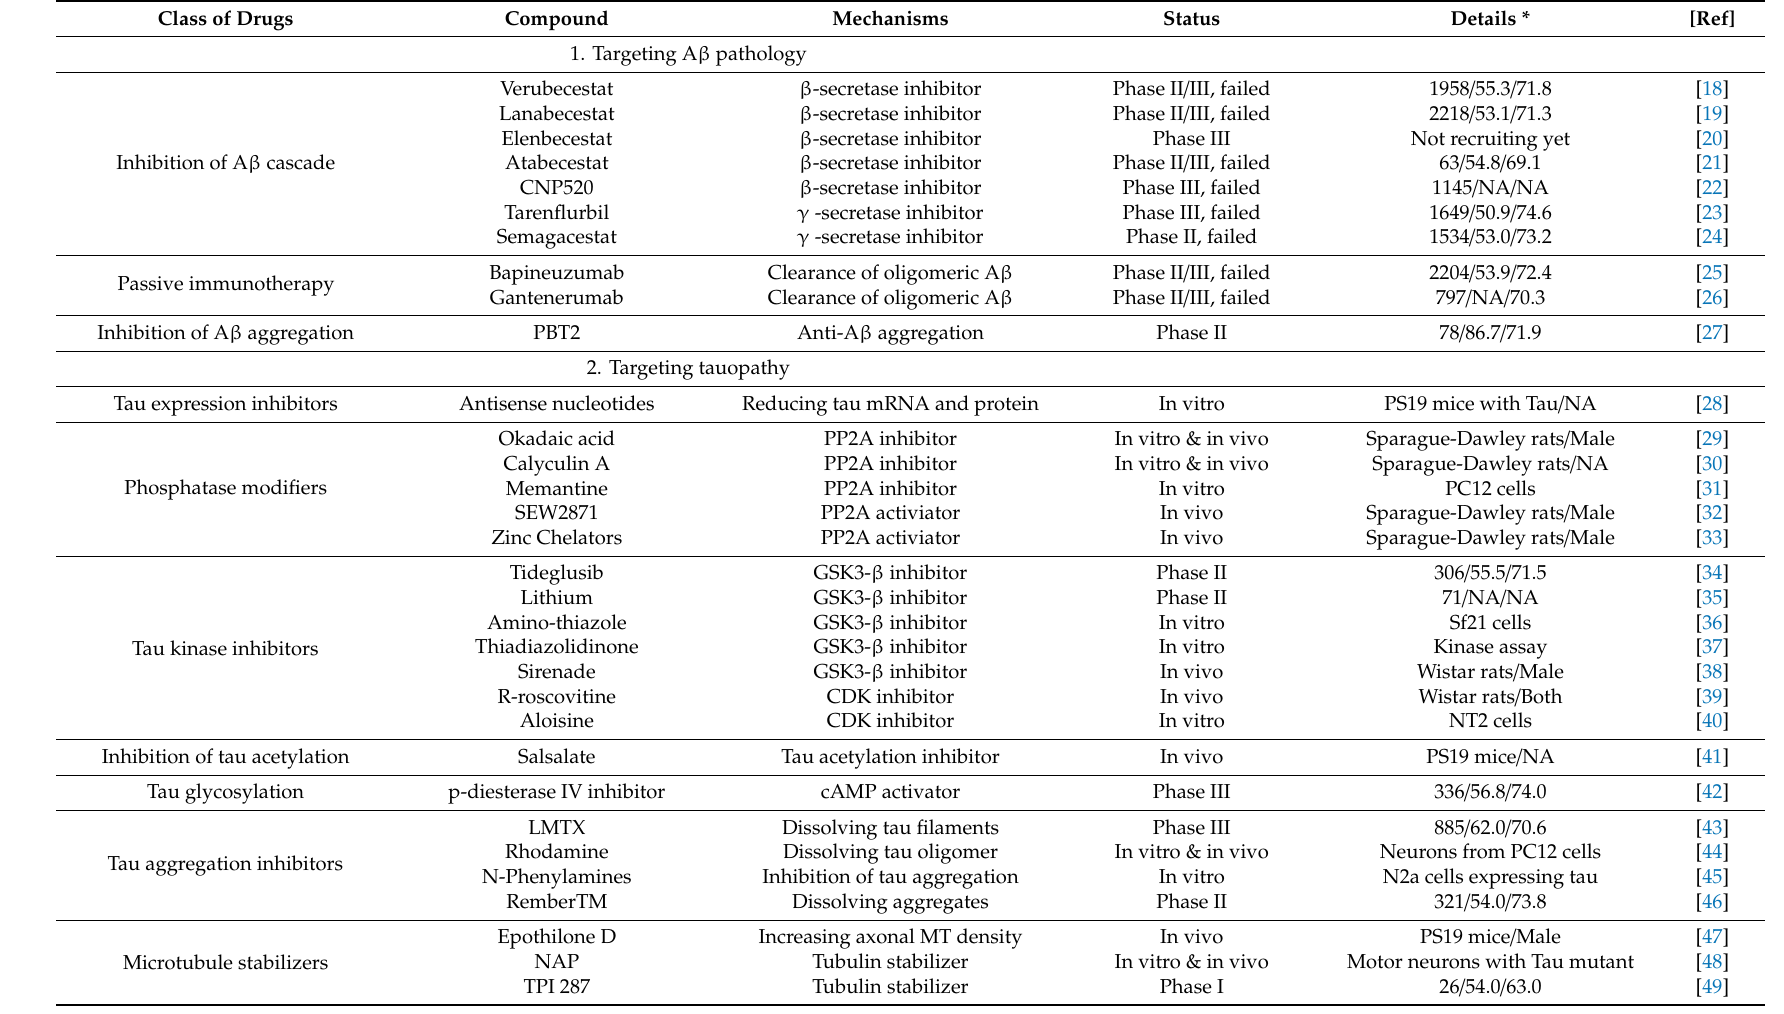
Table 1. List of drugs for the current treatment or potent treatment for Alzheimer’s